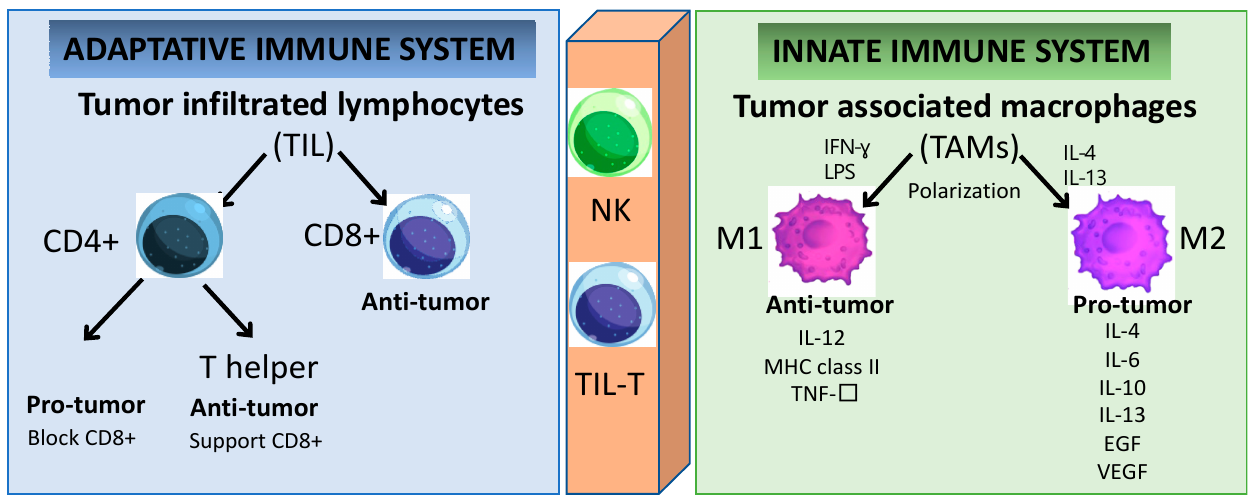
Figure 2. Immune cells play a key role in tumor cell growth and dissemination. Cells of the innate immunity branch provide a rapid response to non-self-antigens. In contrast, cells of the adaptive immunity branch provide a slower but specific response. Several cell subsets, including TIL and NK cells, connect both branches of immunity because they express receptors similar to those in conventional B and T cells. Even though the specificity of these receptors is limited, the response to specific non-self-antigens is prompt.